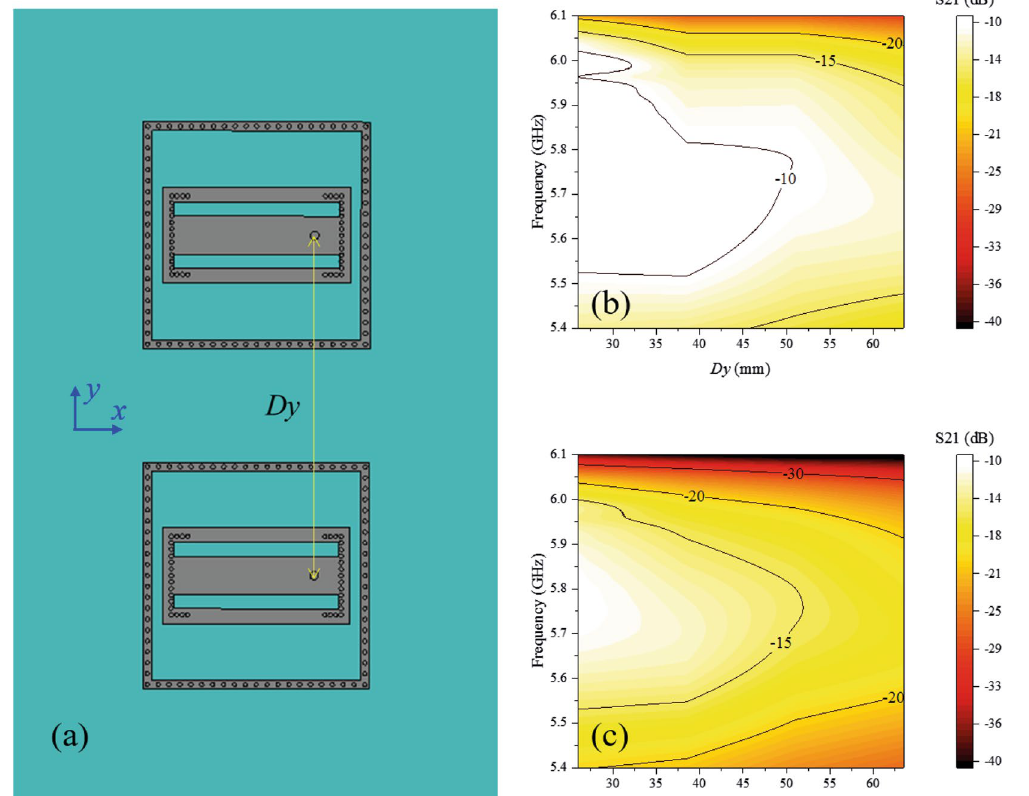
Figure 9. Relations between the distance Dy and element coupling. ( a ) Schematic of the array with two elements arranged along the y direction. ( b ) S21 versus different distance Dy when the antennas have no decoupling cavities. ( c ) S21 versus different distance Dy when the antennas have decoupling cavities. The mutual coupling decreases with the distance Dy in both two cases, and S21 map in ( c ) is approximately 5 dB weaker than that in ( b ), which means the decoupling cavity can weaken the mutual